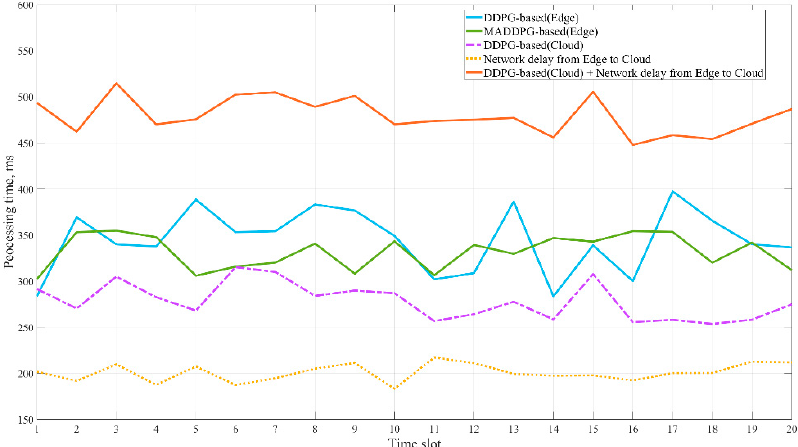
Figure 7. The processing time of different models working on the situational environment within 20-time slots.